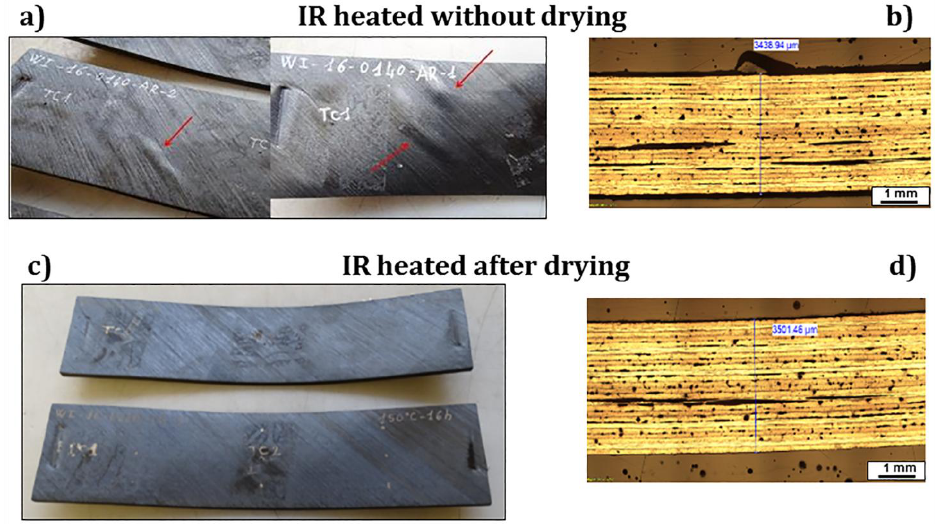
Figure 5. Defects of blank laminates after IR heating: ( a ) and ( b ) without drying; ( c ) and ( d ) after drying at 150 °C for 16 h.